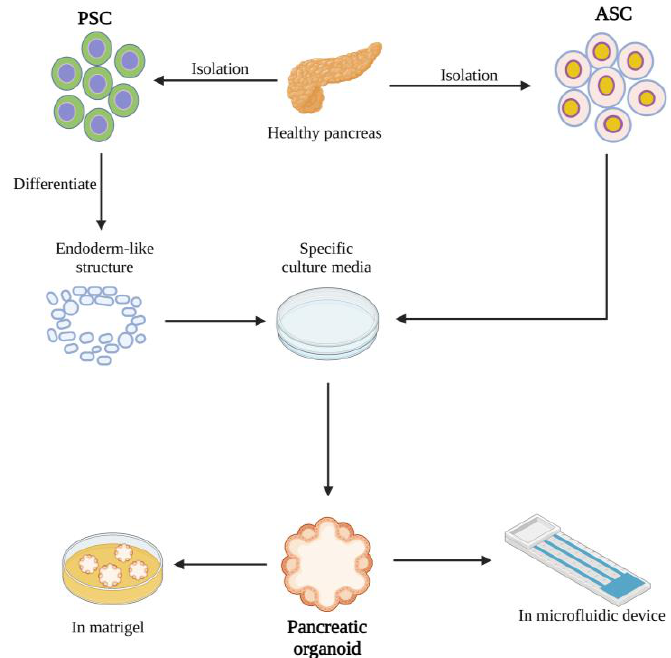
Figure 1. Pancreatic organoids can be constructed in a variety of forms. Pancreatic organoids